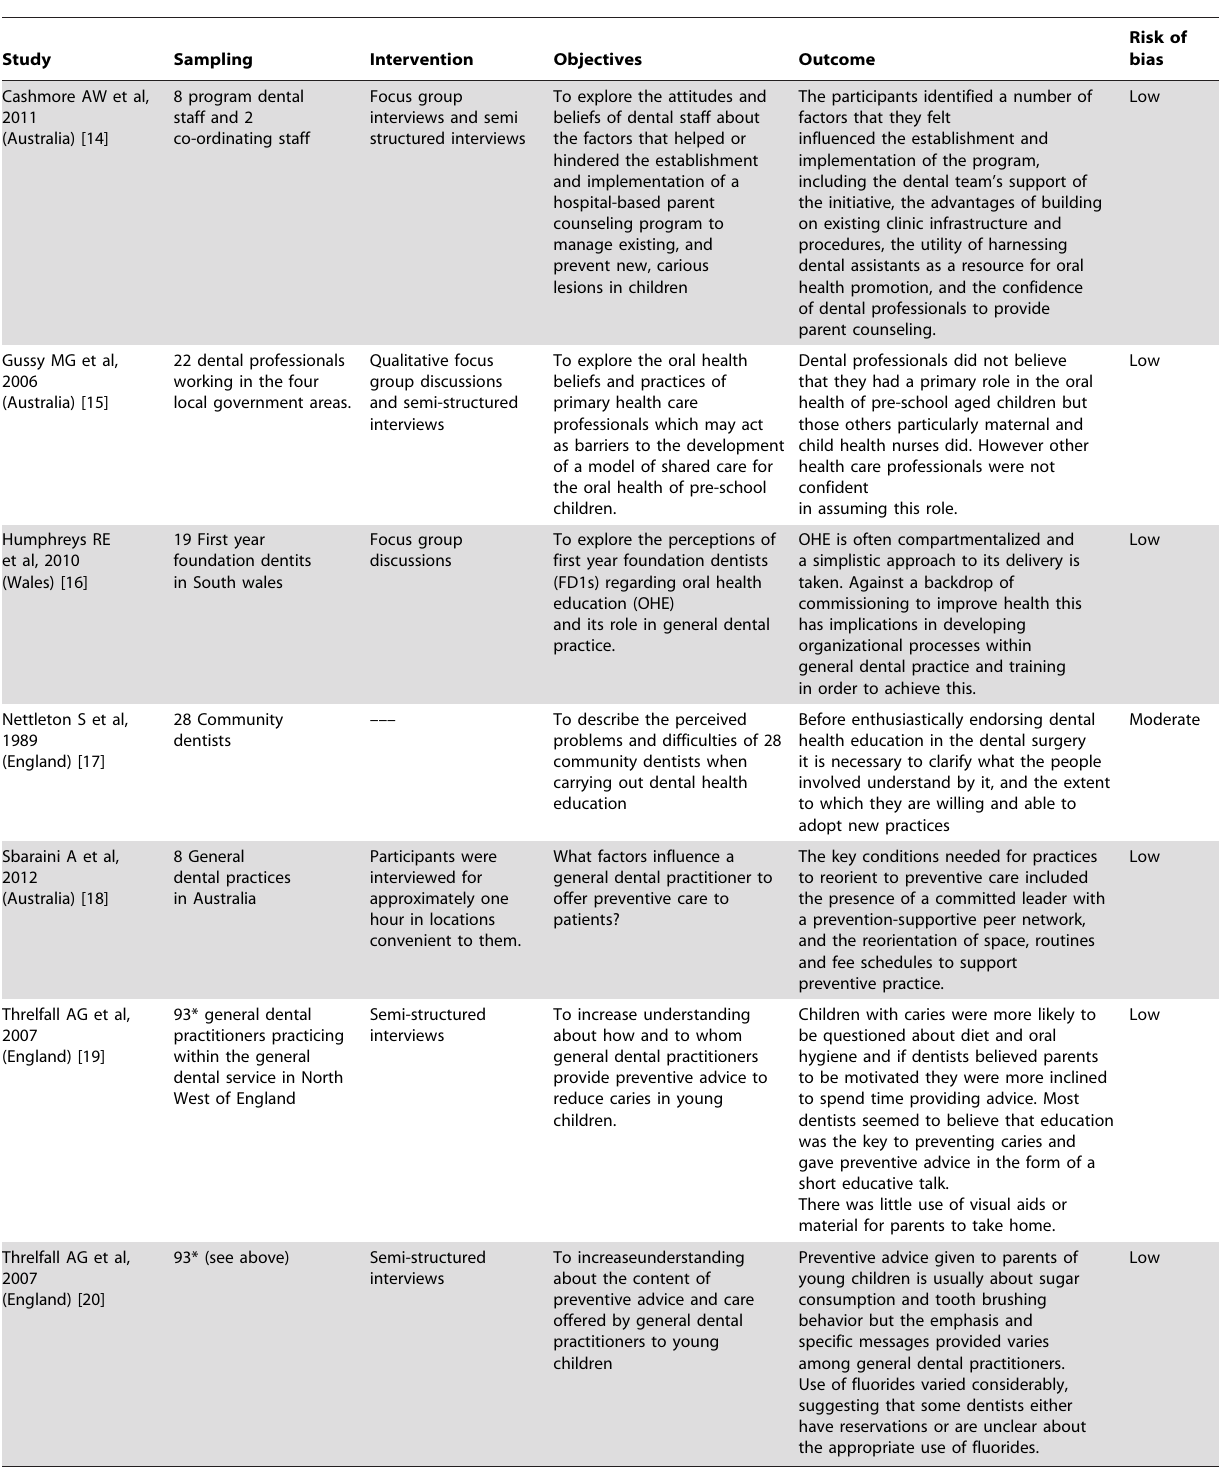
Table 1. Publication characteristics of the qualitative studies included in the